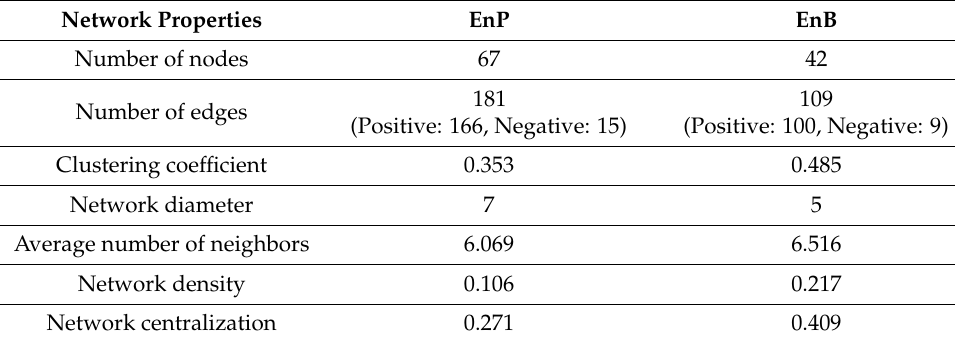
Table 2. Network properties of